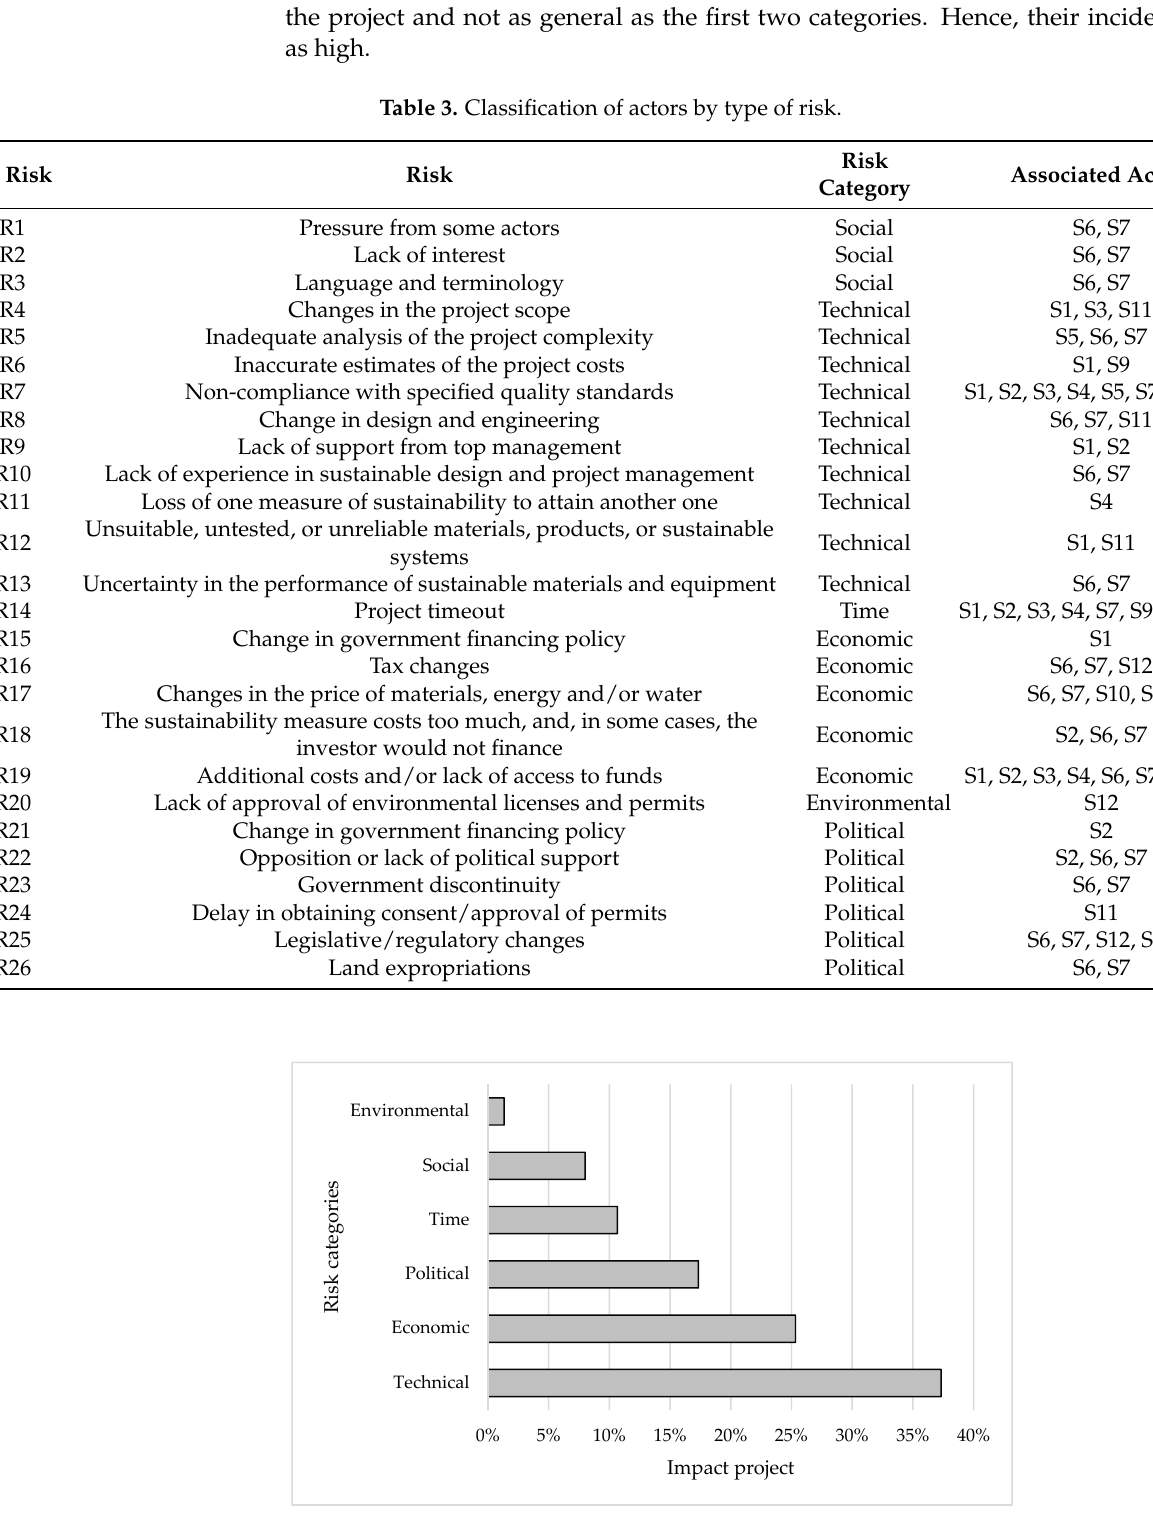
Table 4. Classification of risks by type of actor.